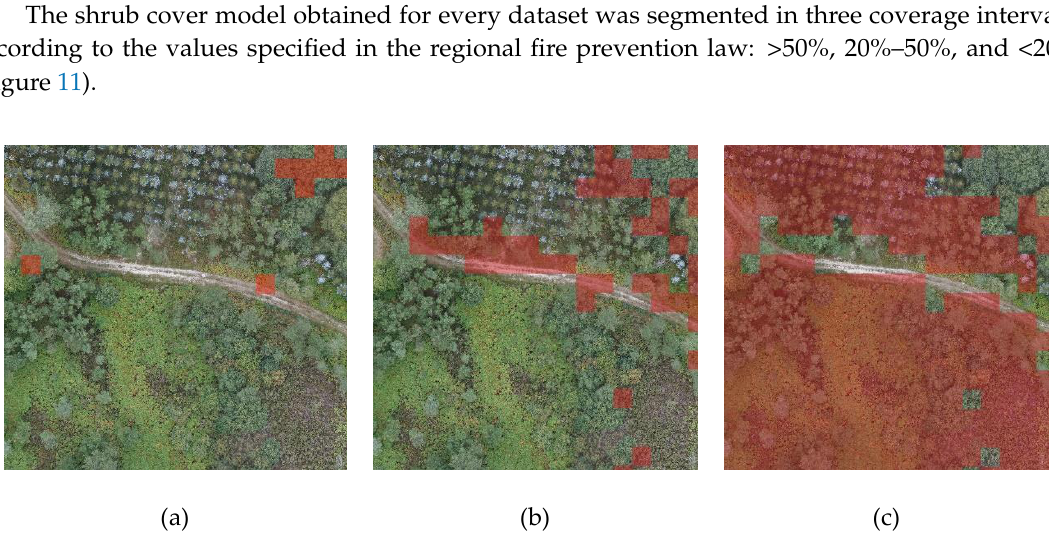
Figure 11. Results of shrub characterization: red color represents the shrub with a cover of <20% in ( a ); the shrub with a cover between 20% and 50% ( b ); and the shrub with a cover of >50% ( c ).